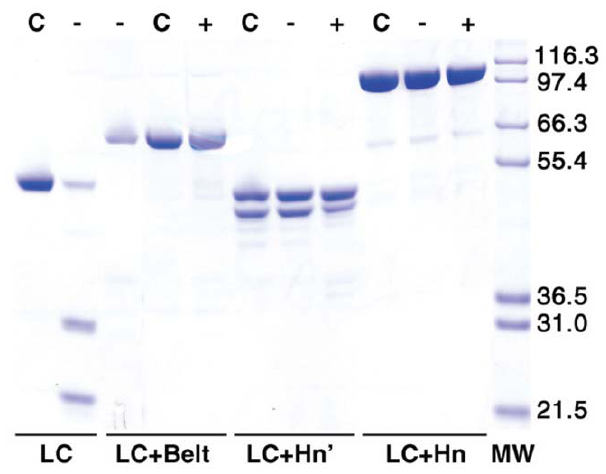
Figure 8. Reducing SDS-PAGE of LC variants before (C), and after 48-h incubation at 22 u C in the absence ( 2 ) and presence ( + ) of 5 mM DTT. Samples (0.15 mg/ml) were heated at . 95 u C for 5 min in the SDS-load buffer containing 5% b -mercaptoethanol before electrophoresis. Molecular mass in kDa of the marker proteins in the right lane are shown at